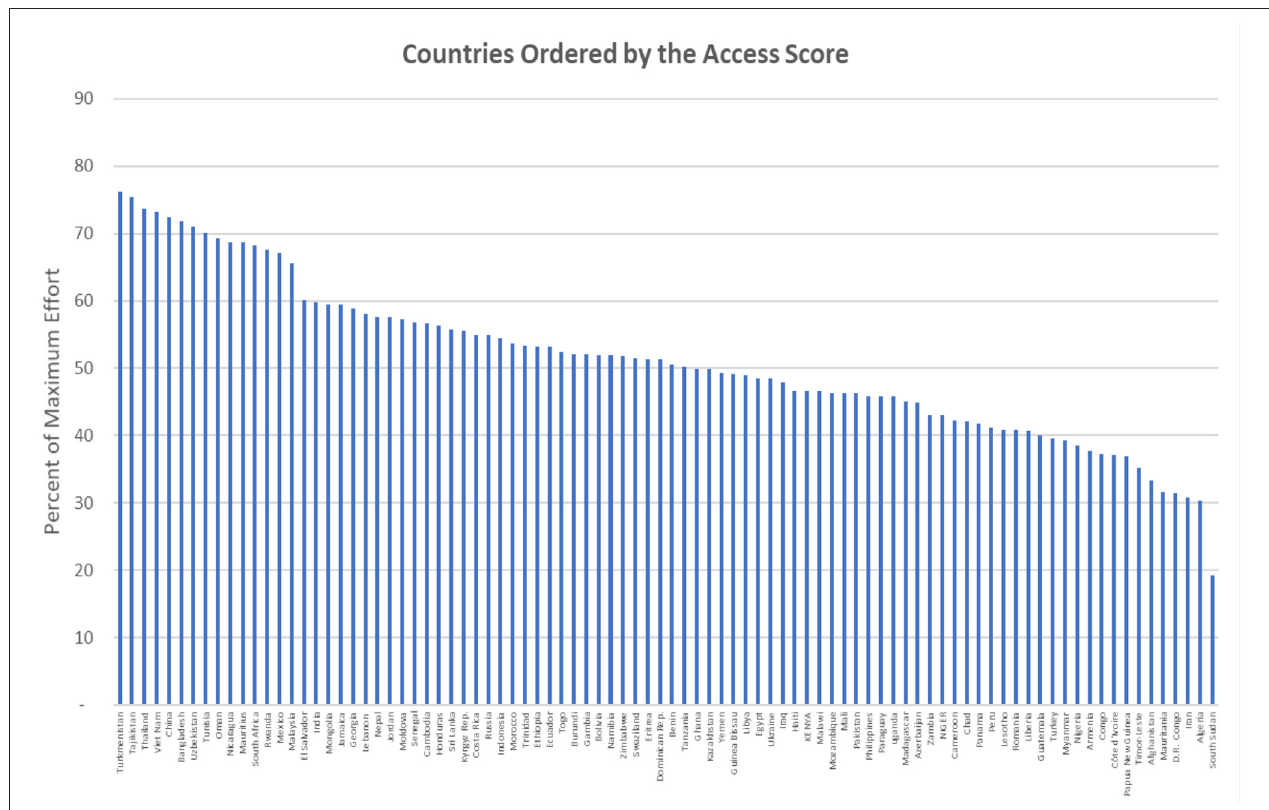
FIGURE 10 | Countries ordered by the access